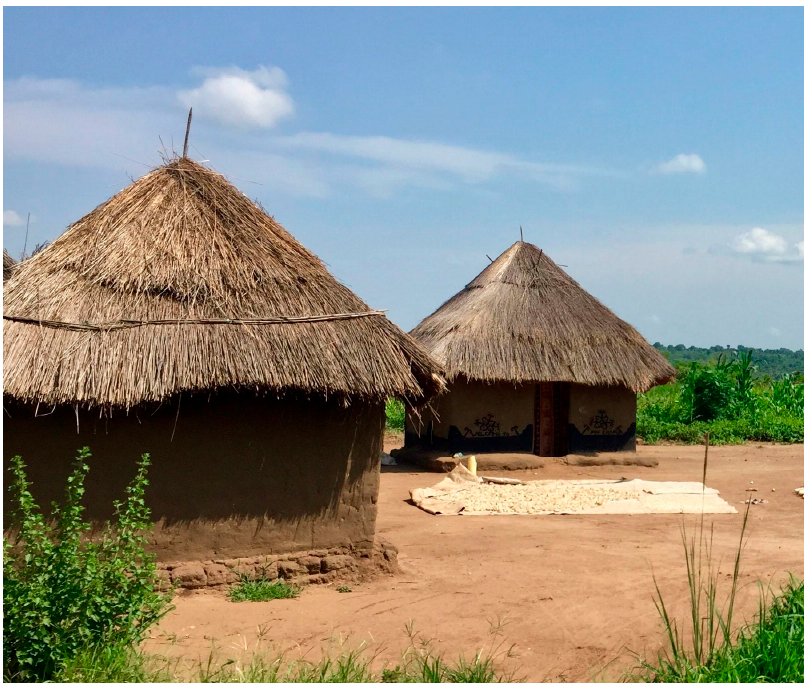
Figure 2. These are typical homes in the Yumbe District of northern Uganda. The residents are drying sorghum. Photograph taken by Tim Berke, 2019.